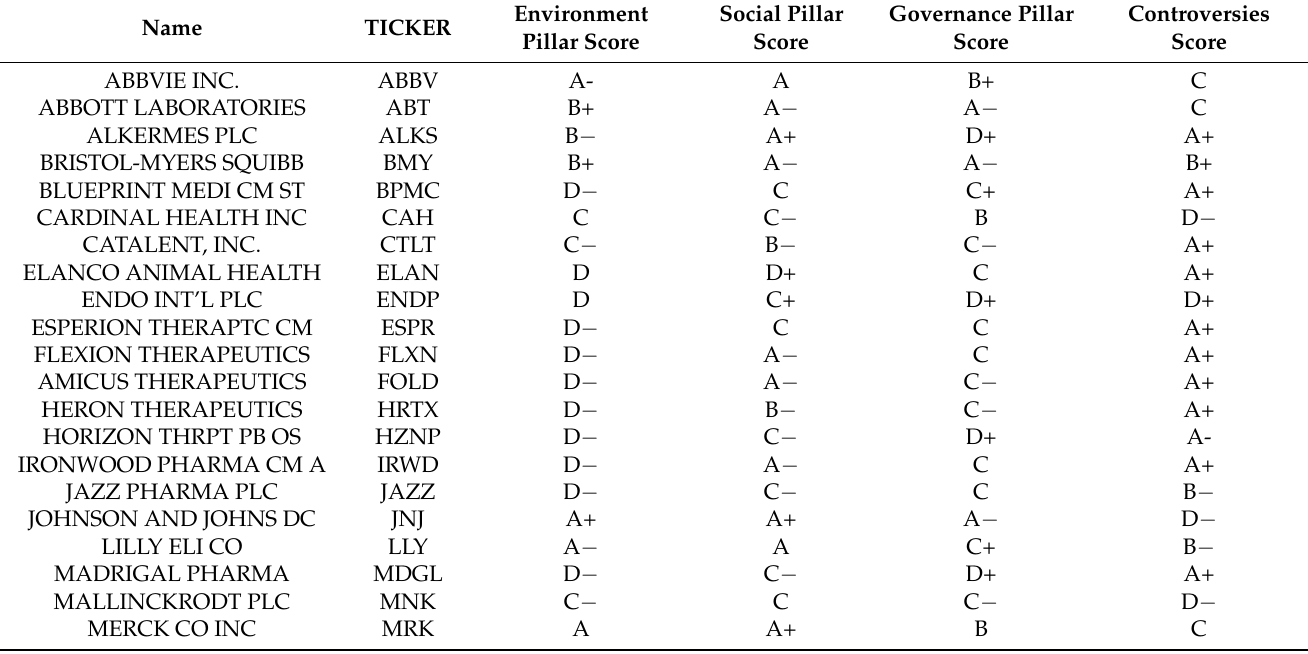
Table A1. List of Nasdaq US Smart Pharmaceuticals Index and their values of ESG and controversies